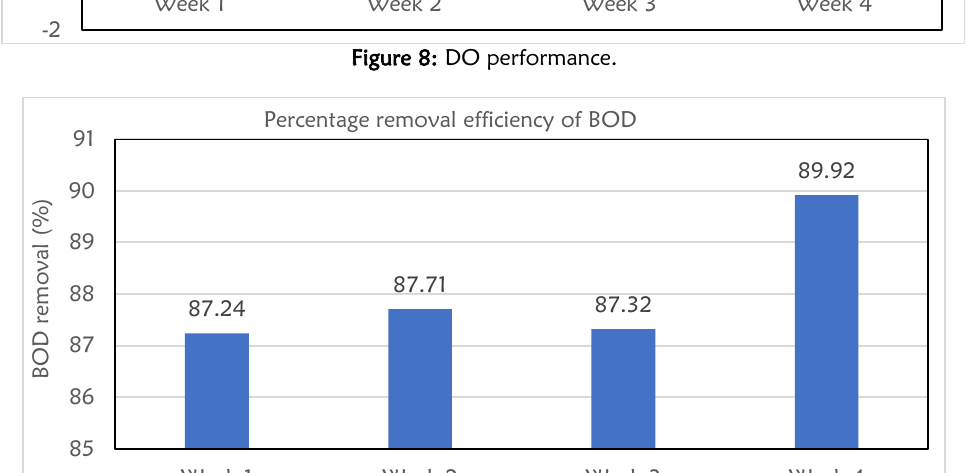
Figure 8: DO performance.